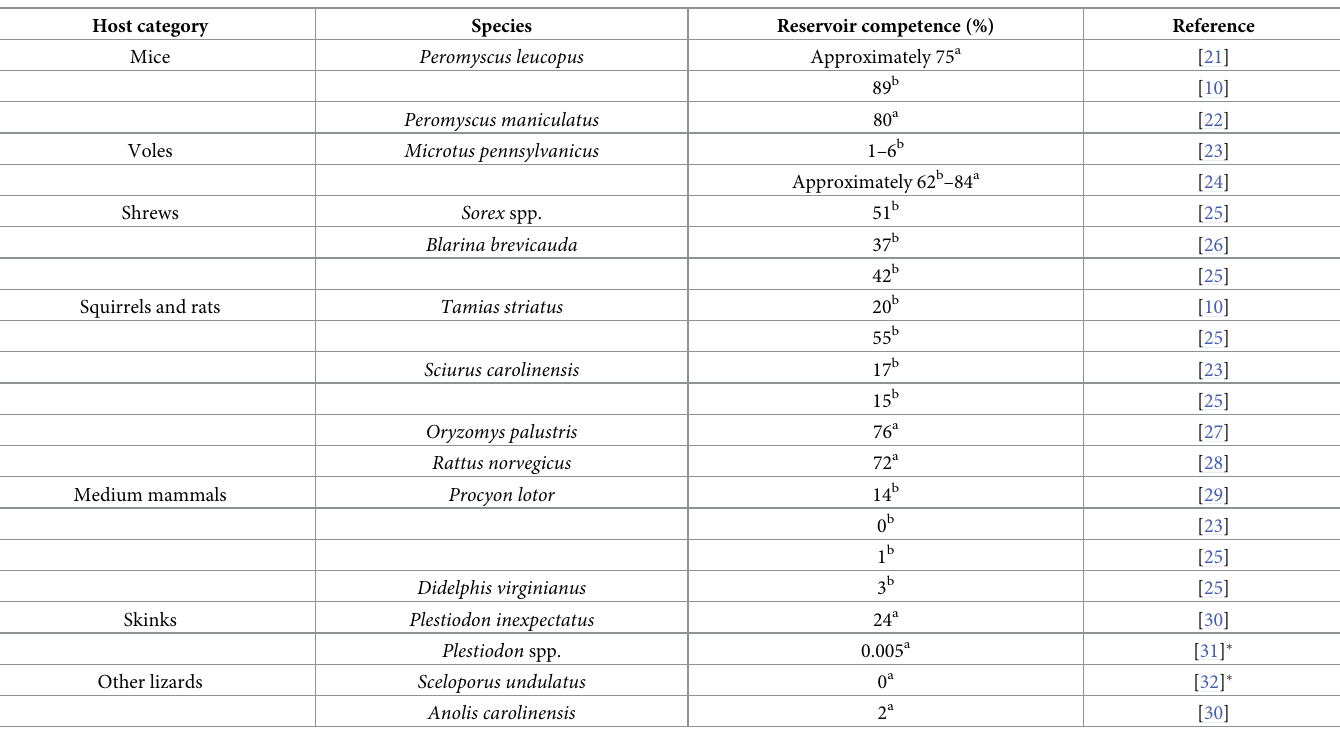
Table 1. Reservoir competence of species in different categories of tick